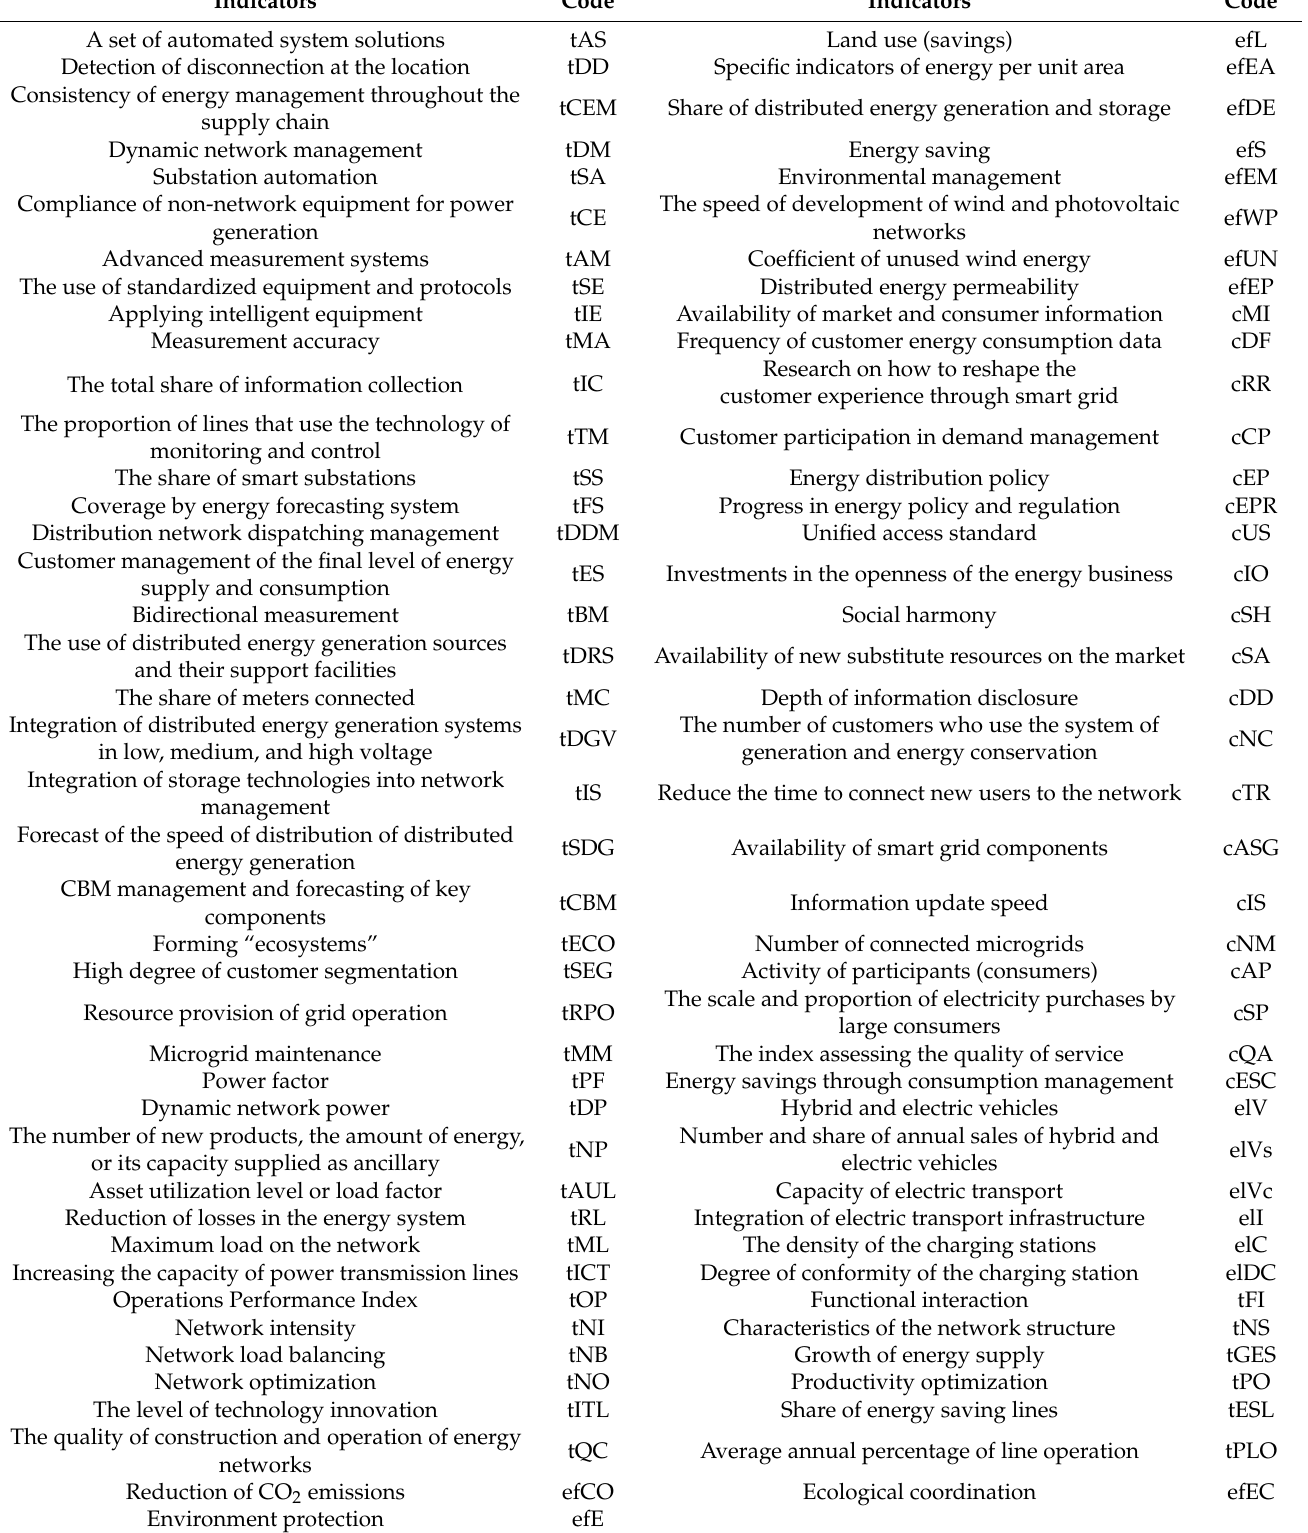
Table A2. Indicators by groups: technical efficiency, environmental friendliness, communication efficiency, and availability of electric transport